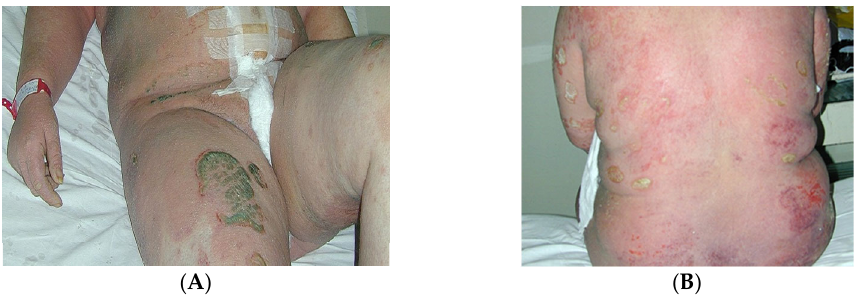
Figure 2. ( A ) Patient 24 h postpartum with generalised pustular psoriasis (von Zumbusch psoriasis). ( B ) Detail — the pustules are sterile and amicrobial, formed through an immune mechanism.